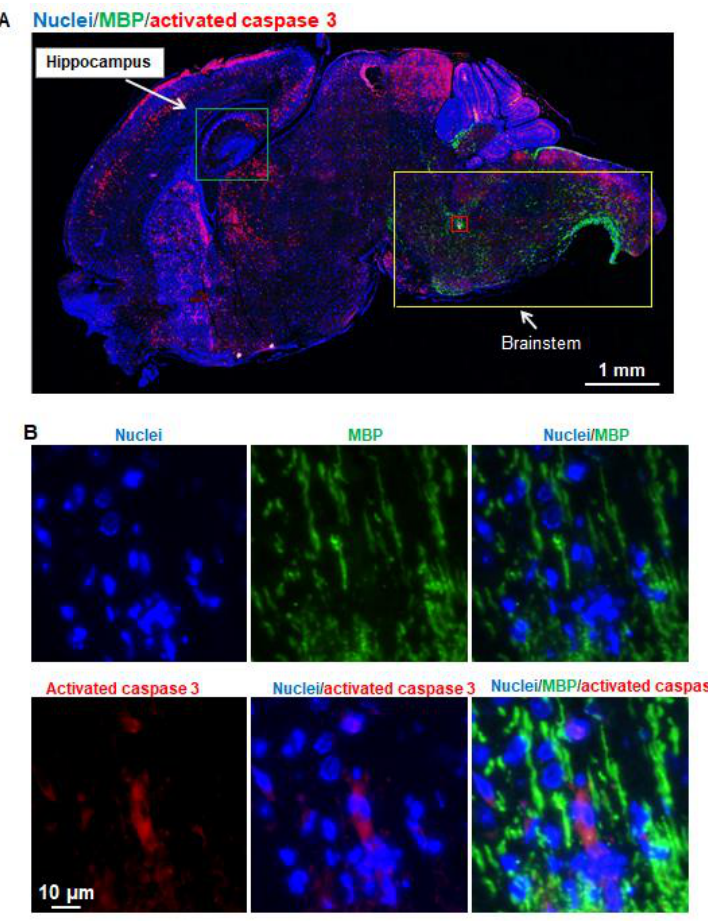
Figure 5. Propofol does not trigger apoptosis in oligodendrocytes in the hippocampus. In all images of Figure 5, Blue, green, and red represent cell nuclei, myelin basic protein (MBP; oligodendrocyte marker), and activated caspase 3 signals, respectively. ( A ) Fluorescent images of sagittal section of mouse brains treated with propofol. MBP were barely detected in hippocampus marked by green box and other brain regions with severe apoptosis (e.g., cortex). Compared with the MBP and apoptotic signals in vulnerable brain regions, stronger and more MBP signals were observed in brainstem including midbrain, pons, and medulla regions marked in the yellow-boxed view, while fewer activated caspase 3 signals were detected in these regions, suggesting that brain regions with advanced myelination are not vulnerable to propofol; ( B ) The magnified view of the red-boxed region shown in Figure 5A. These images include the individual channel and overlaid images, and show that activated caspase 3 and MBP signals were not co-localized in the same cells, suggesting that propofol does not induce oligodendrocyte apoptosis. Scale bars = 1 mm ( A ) or 10 µ m ( B